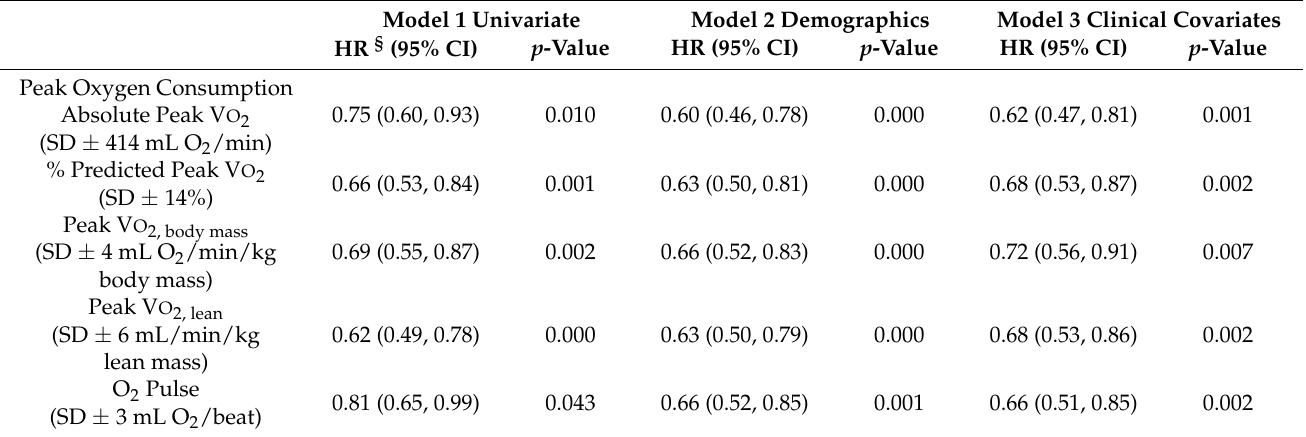
Table 2. Hazard Associated with each Standard Deviation Change in Peak V O 2